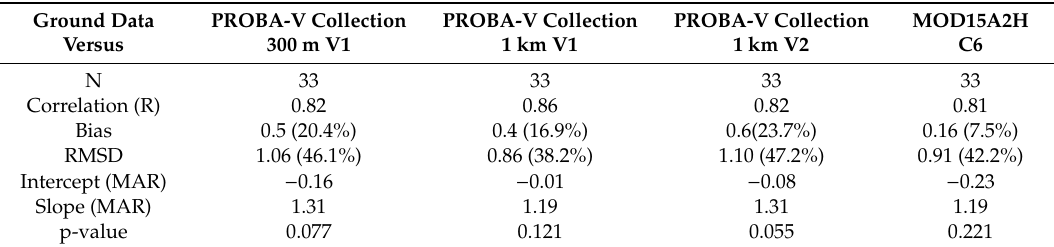
Figure 8. Comparison of the satellite LAI products (Collection 300 m V1 ( a ), Collection 1 km V1 ( b ), Collection 1 km V2 ( c ) and MODIS C6 ( d )) with ground-based maps. Numbers indicate the sample (Table 2) and colours indicate the site (legend in Figure 10). Dashed lines correspond to the 1:1 line and optimal and target requirements, and the red line corresponds to the linear fit using MAR. Table 11. Accuracy assessment with ground measurements statistics for different satellite LAI products at 3 km spatial resolution. Relative values (%) are shown in brackets.